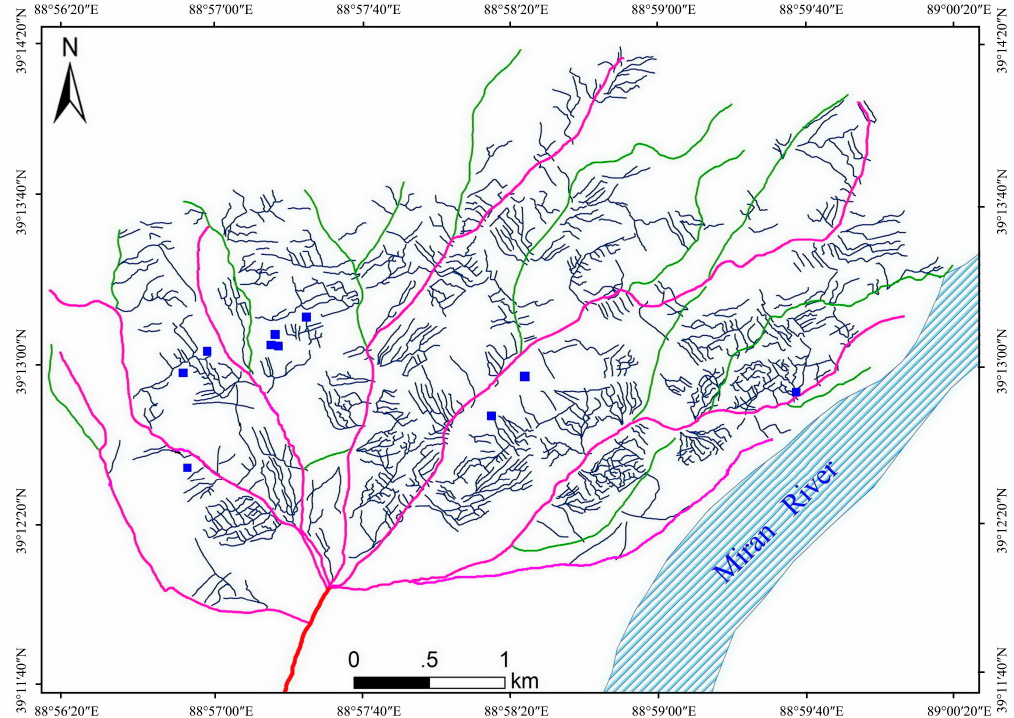
Figure 10. Map of the canal-based tuntian irrigation system in the Miran site. It is a fan-shaped complex that includes trunk LATTICs (red), primary LATTICs (pink), secondary LATTICs (green), and tertiary LATTICs (dark blue). The blue blocks indicate the earthen monuments.